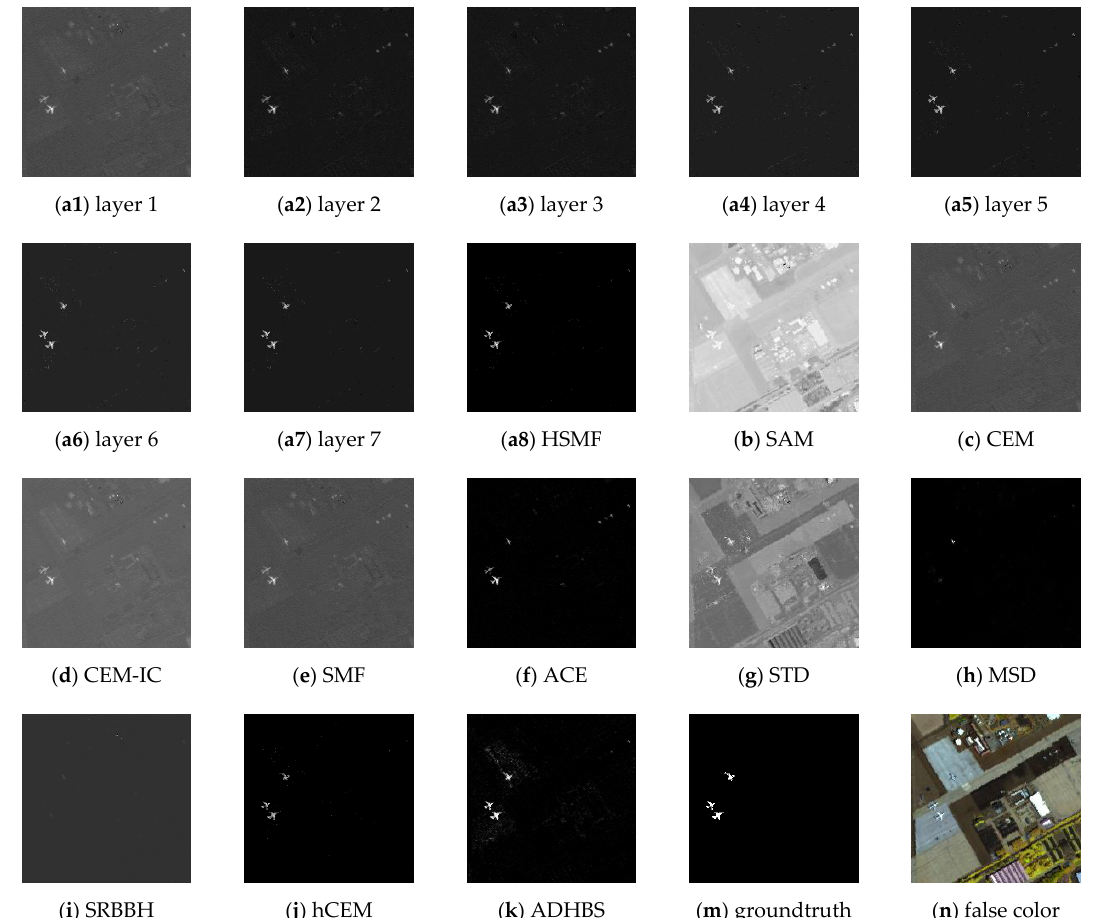
Figure 3. Detection results of different detectors on the San Diego Airport data. ( a1 – a7 ): results of HSMF for the first to the seventh layers. ( a8 ): The final result of HSMF. ( b – k ): Results of spectral angle mapper (SAM), constrained energy minimization (CEM), inequality constraint on CEM (CEM-IC), spectral matched filter (SMF), adaptive coherence estimator (ACE), sparsity-based target detector (STD), matched subspace detector (MSD), sparse representation-based binary hypothesis (SRBBH), hierarchical CEM (hCEM), and angle distance-based hierarchical background separation (ADHBS). ( m ): The groundtruth information. ( n ) The false color image (bands 11, 40, 88).